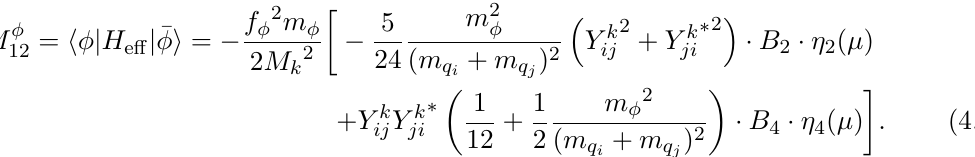
(cid:0) B 0 mixing d d